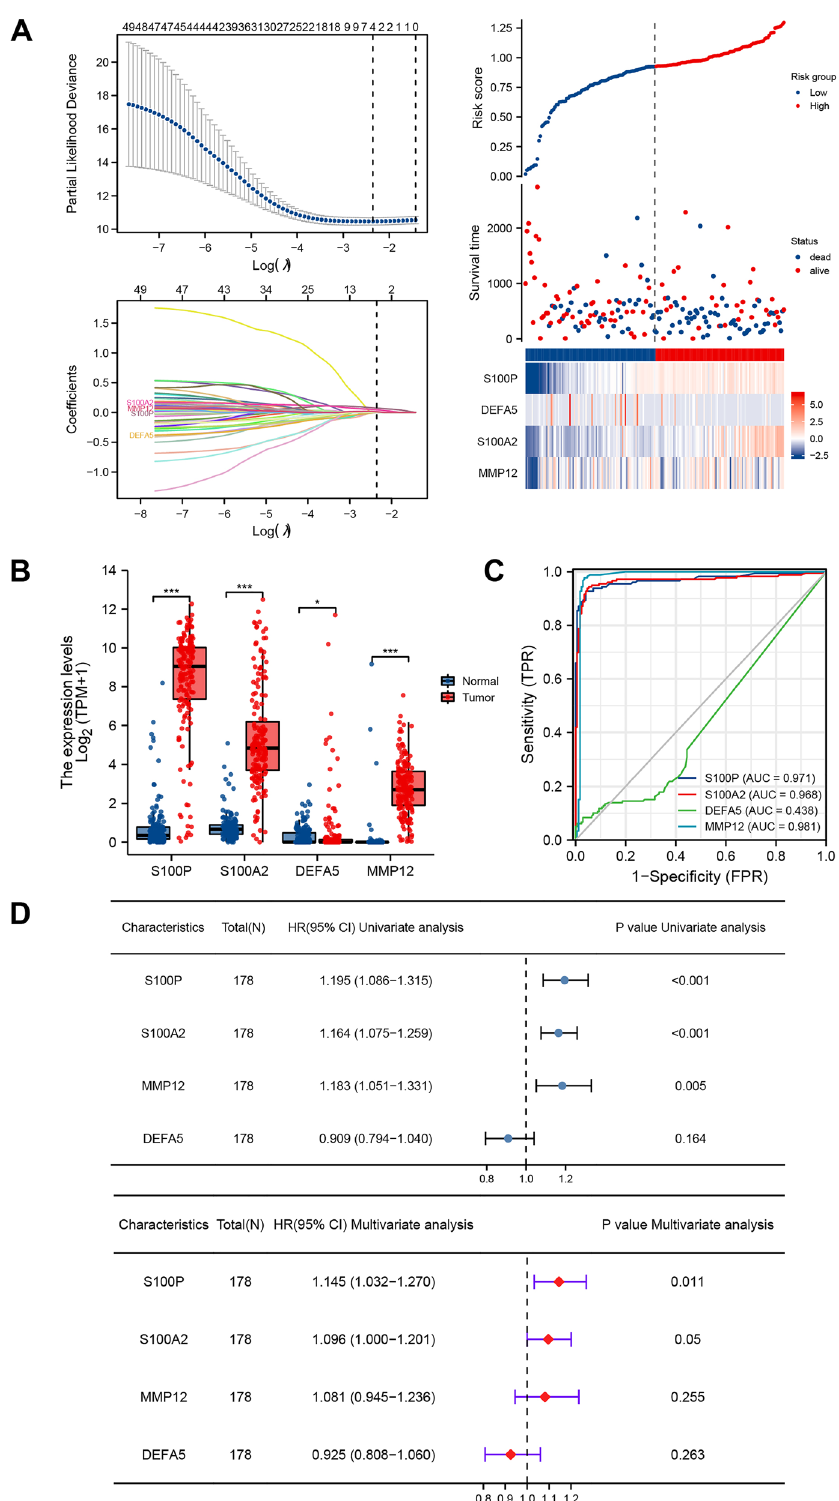
Figure 3. Establishment of IRGs signature (IRGS). ( A ) Ten-time cross-validation for tuning parameter selection in the Lasso regression model and risk analysis of four immune-related genes in patients with PAAD; ( B ) differential expression of four IRGs between tumor and normal tissues of patients with PAAD; ( C ) diagnostic value of four IRGs for patients with PAAD; ( D ) univariate and multivariate COX analysis of four IRGs is shown in forest map. * P < 0.05, ** P < 0.01, *** P <